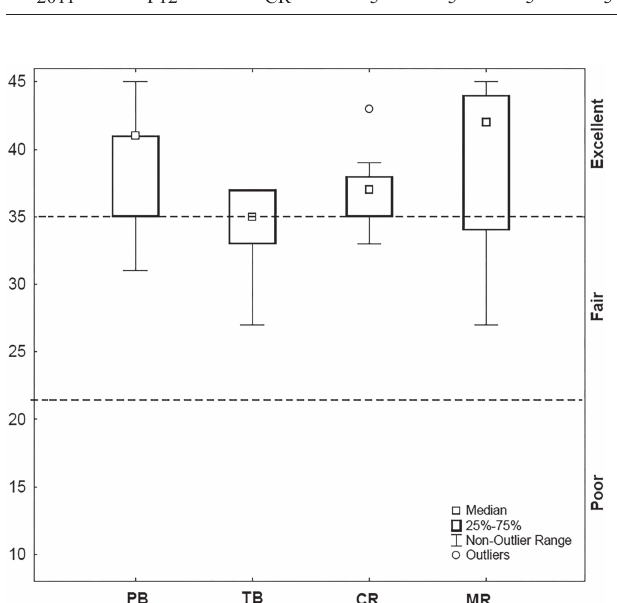
in the strata sampled for PNP